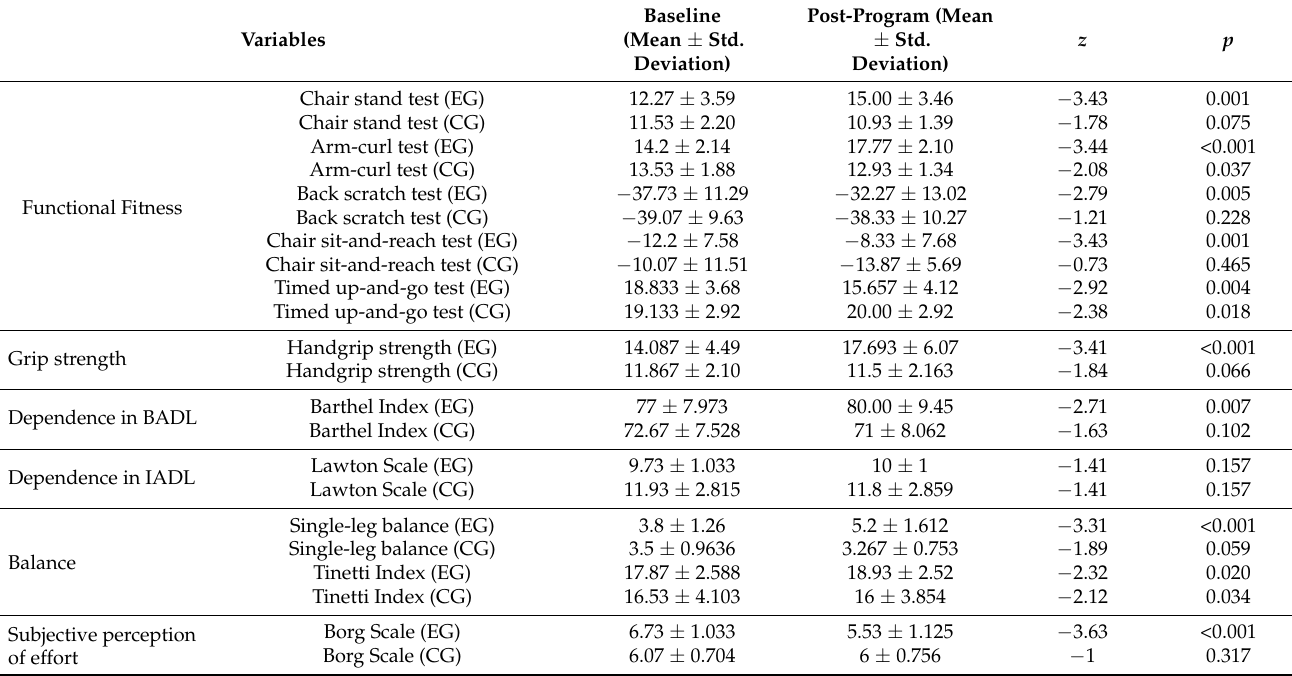
Table 4. Evaluations obtained at baseline and post-program for the variables of functional fitness, BADL, IADL, grip strength, balance, and subjective perception of effort. Baseline Post-Program (Mean ± Std. Variables (Mean ± Std.